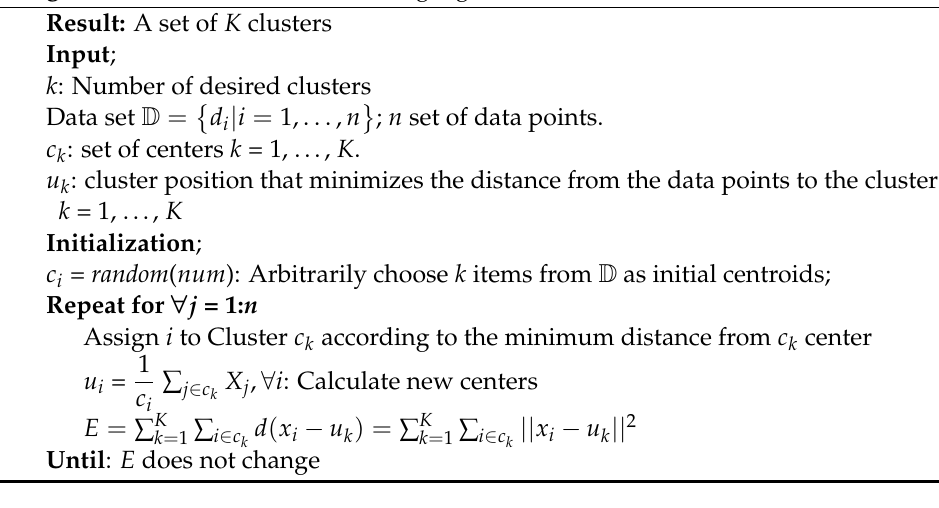
Algorithm 2: The K -means clustering